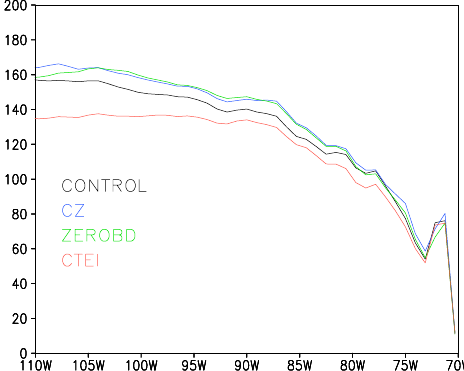
Fig. 12. July 2008 ensemble mean latent heat flux (W/m 2 ) at the surface along 20S